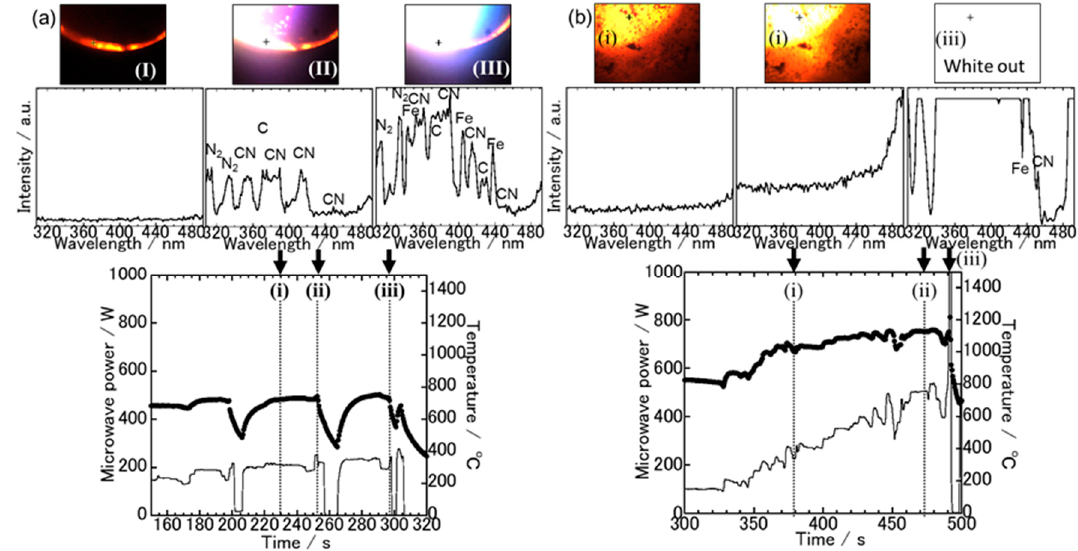
Figure 3. Temperature and microwave power profiles of maghemite and carbon mixture irradiated with an E-field ( a ) and an H-field ( b ). The visible images and spectroscopic spectra at each time, which are indicated by broken lines in each temperature profile, are shown.